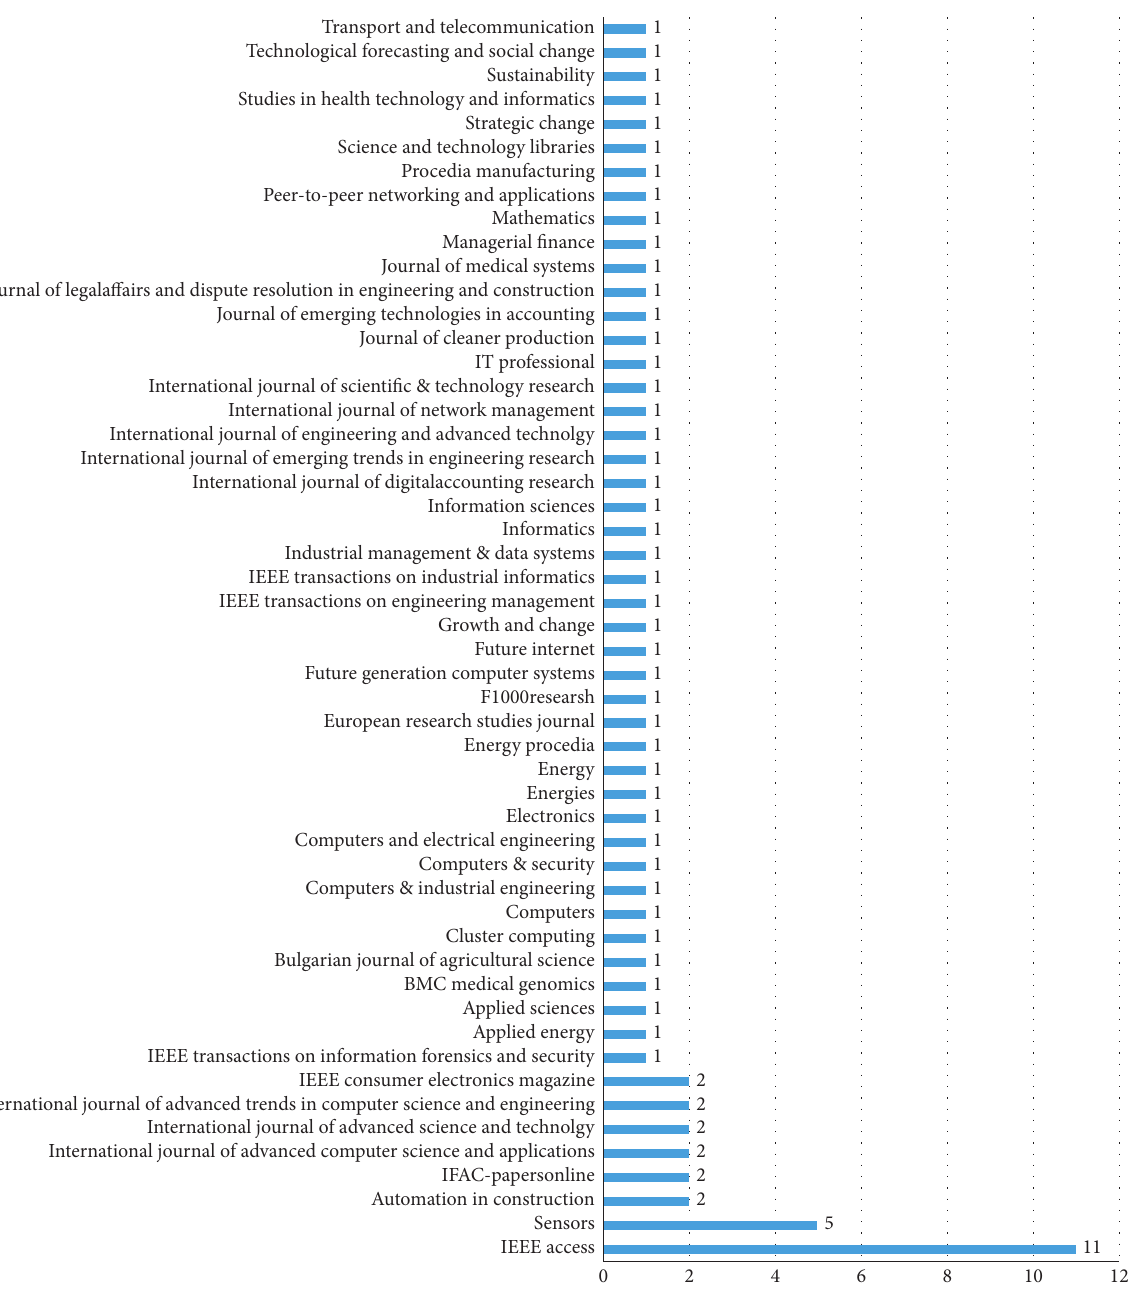
Figure 3: Journal/conference publications and number of papers